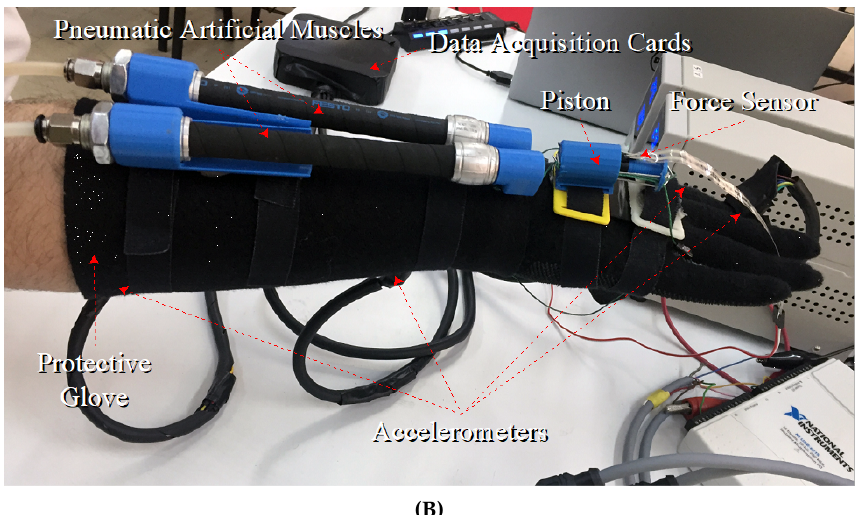
Figure 5. Overview of the exoskeletal glove prototype iterations for applying kinesthetic force to ( A ) the index finger and ( B ) the metacarpal